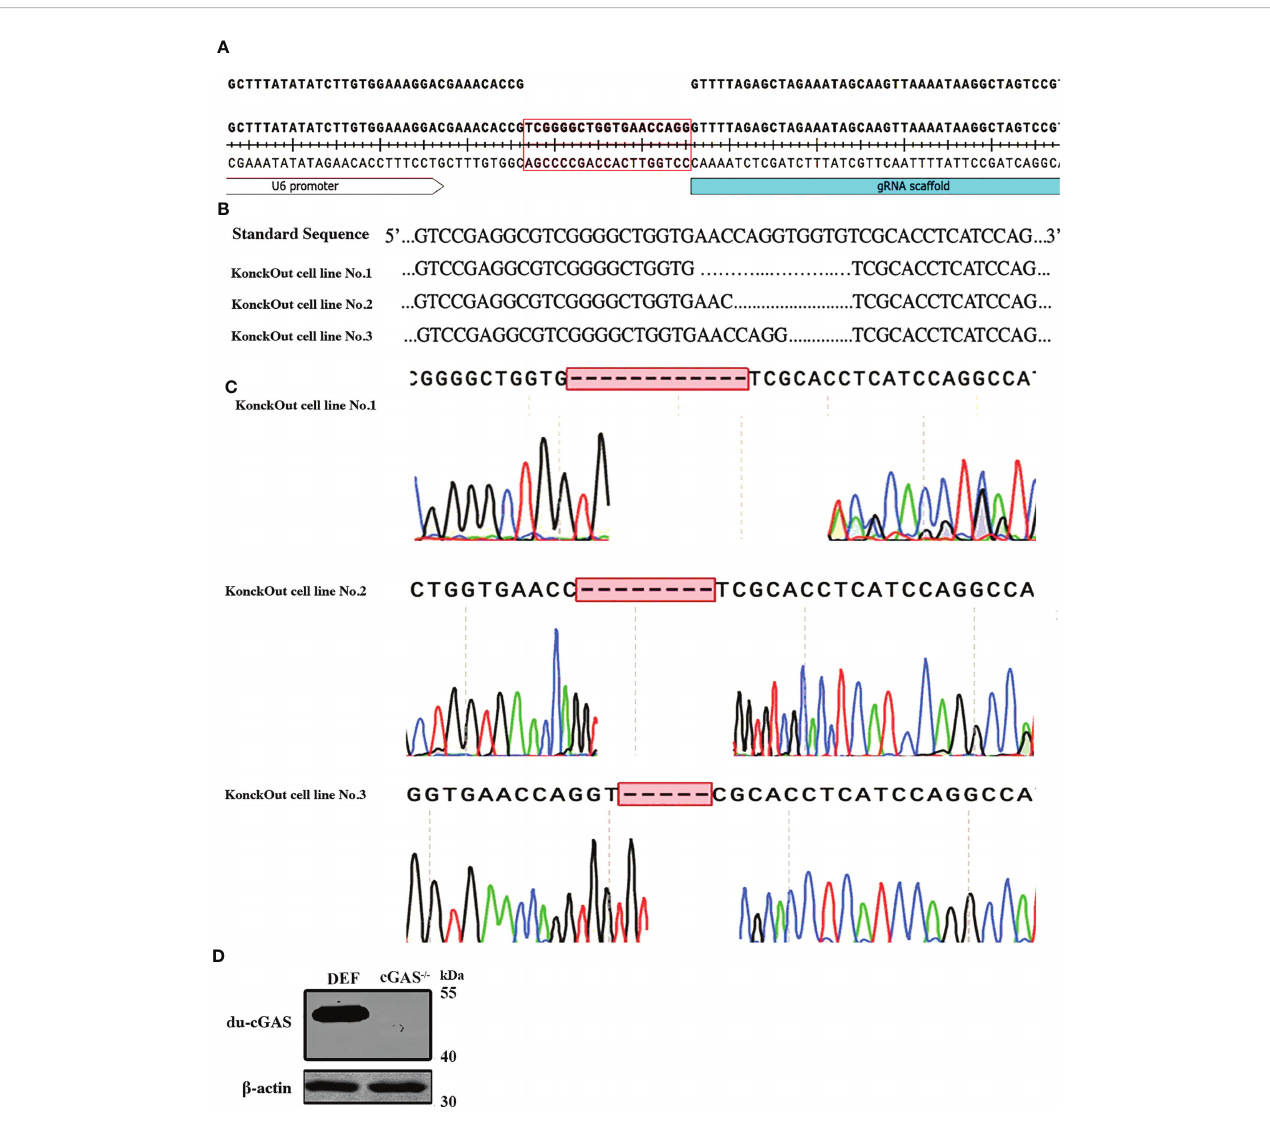
FIGURE 2 Generation and sequencing identi fi cation of the du-cGAS knockout DEF cells. (A) PAM sequence construction. ( B , C ) Genome sequencing of the knockout cell lines. (D) Western blotting analysis of the knockout ef fi